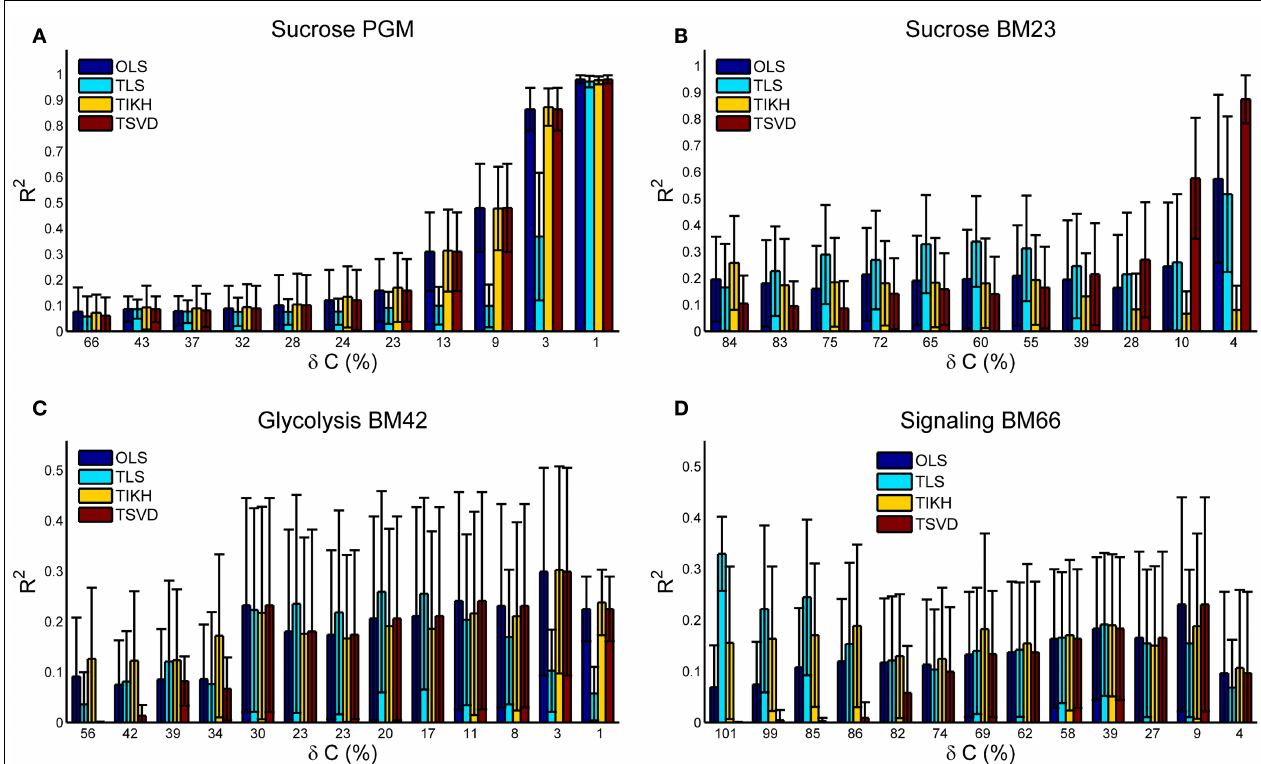
FIGURE 3 | The goodness of the reverse Jacobian obtained by OLS, TLS, TIKH, and TSVD is represented by the R 2 values when regressed to the true Jacobian (vectorized, see Introduction) . (A) is for Sucrose PGM model, (B) for Sucrose BM23 model, (C) for Glycolysis BM42 model, and (D) for Signaling BM66 model. In each sub figure, the error bar with 1 SD is plotted from 100 iterations. Abbreviation: OLS, ordinary least squares; TLS, total least squares; TIKH, Tickhonov regularization; TSVD, truncated singular value decomposition.